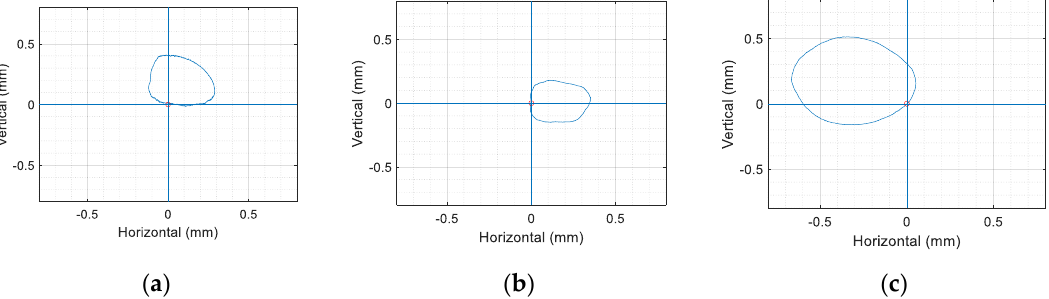
Figure 18. The comparison of the movement characters of the rotating coil at 120 RPM: ( a ) shaft orbit at the DE side; ( b ) shaft orbit at the center; ( c ) the shaft orbit at the NDE side.